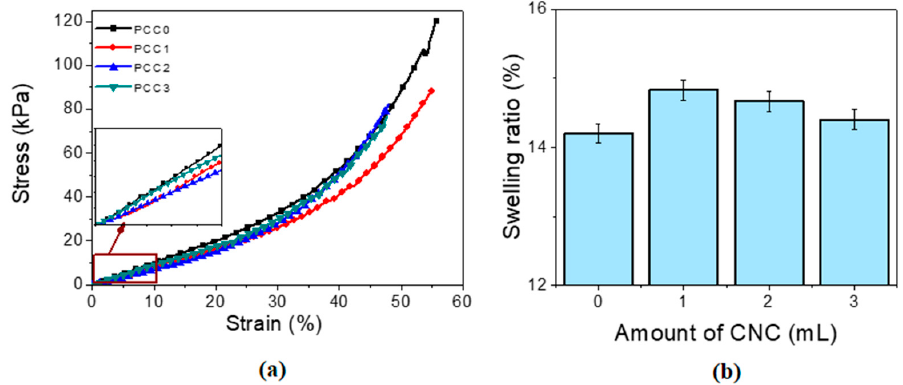
Figure 5. Result for mechanical and swelling tests of PCC hydrogel: ( a ) stress–strain curves and ( b ) swelling ratio.